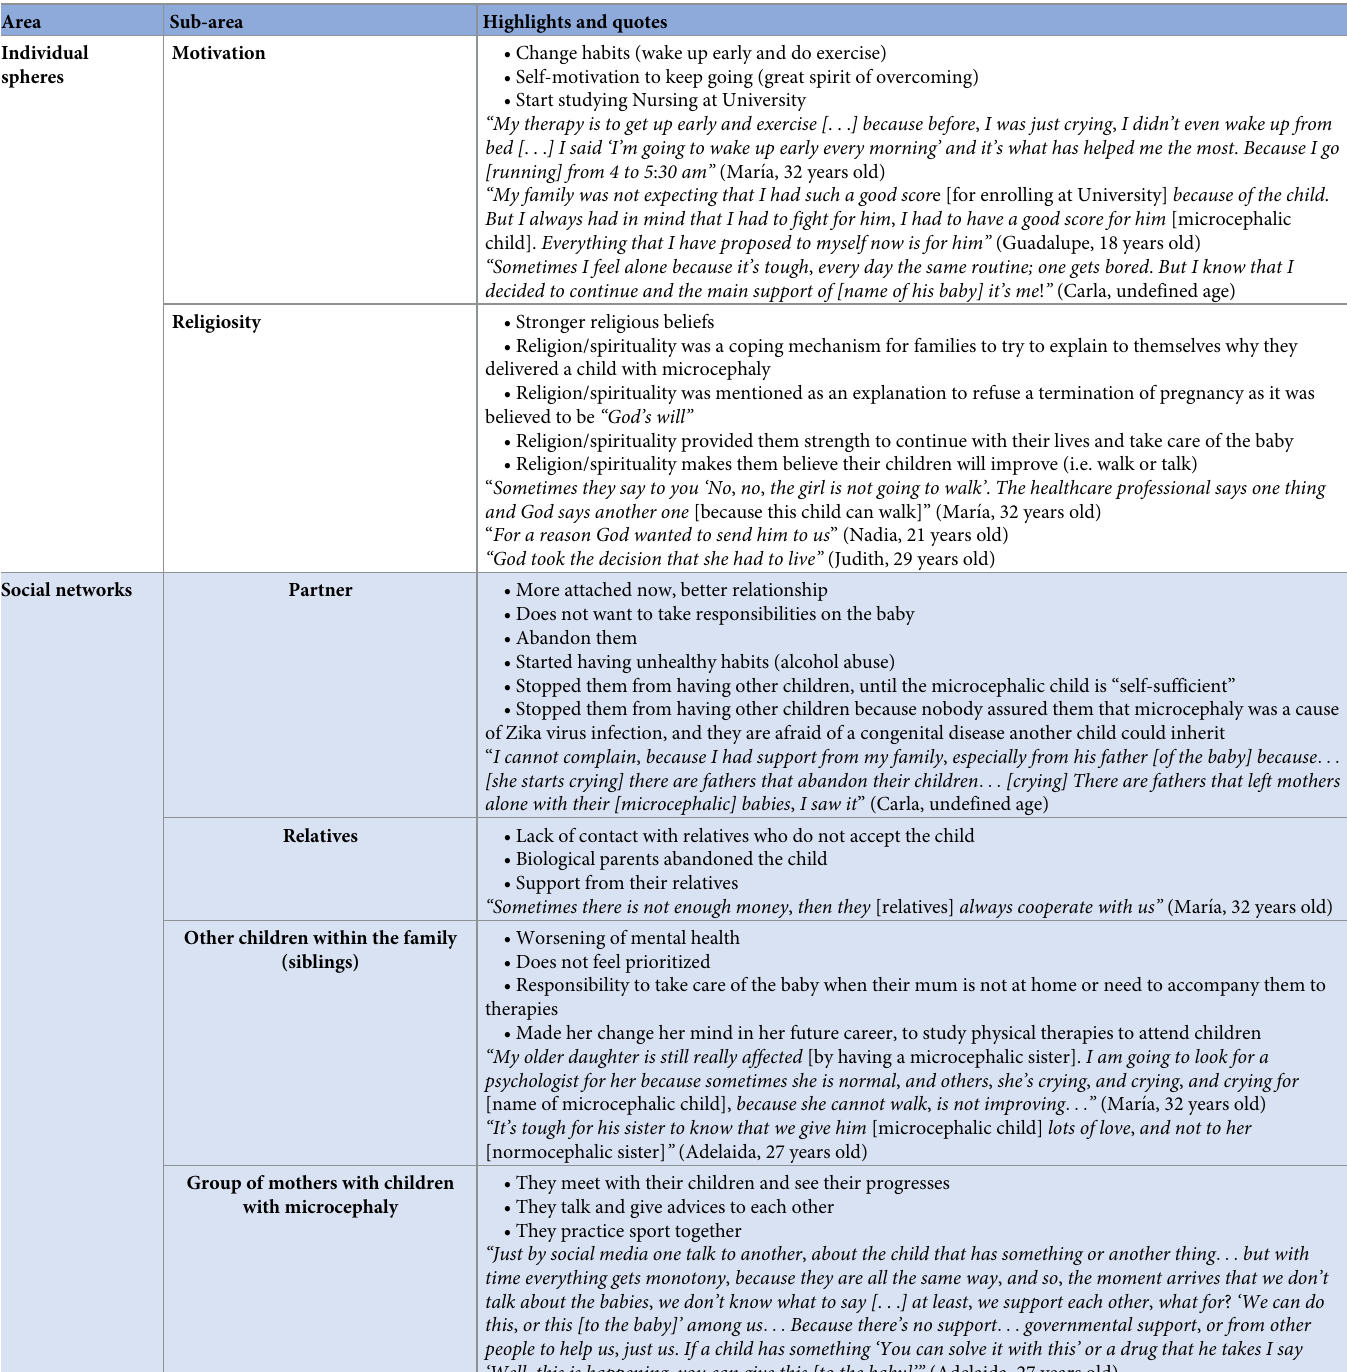
Table 2. Direct and indirect effects on the families with children with ZIKV-associated microcephaly according to participants.